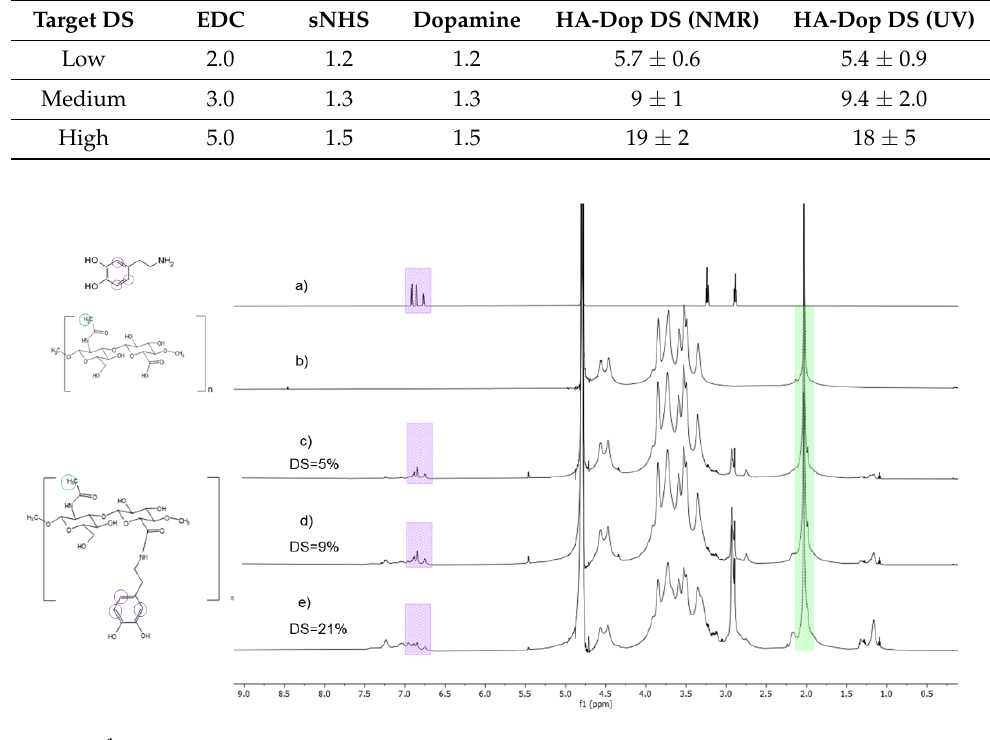
Figure 1. 1 H-NMR spectra of ( a ) dopamine, ( b ) hyaluronic acid (HA), ( c – e ) HA-dop with different DS (acetyl peak outlined in green, dopamine in purple). Table 1. Molar equivalents of the reactants relative to HA carboxyl and mean DS obtained over n = 3 batches of HA-Dop synthesis ( n = 3).